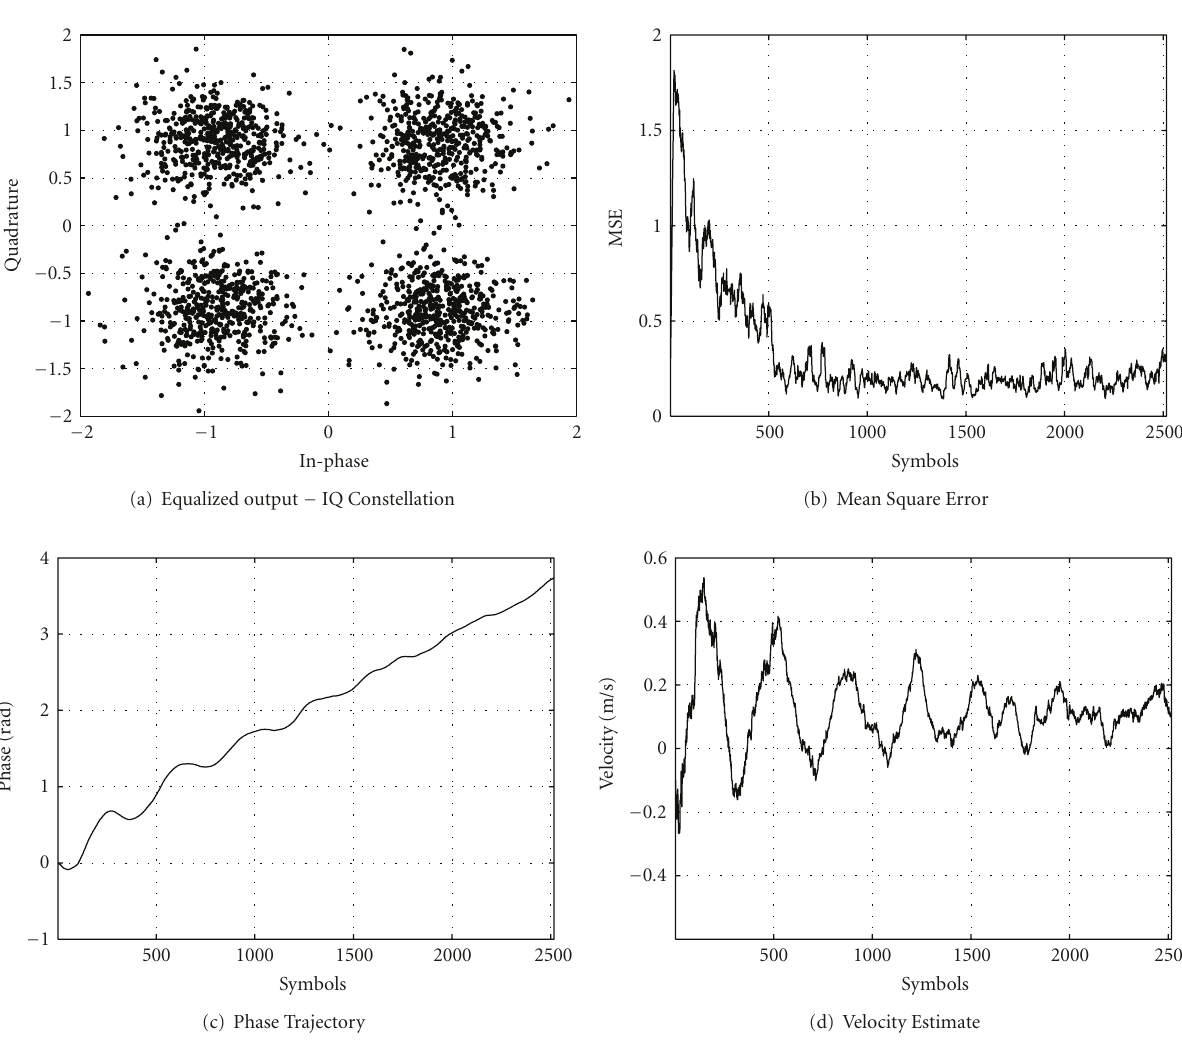
Figure 13: Performance of the proposed receiver after 4th iteration.